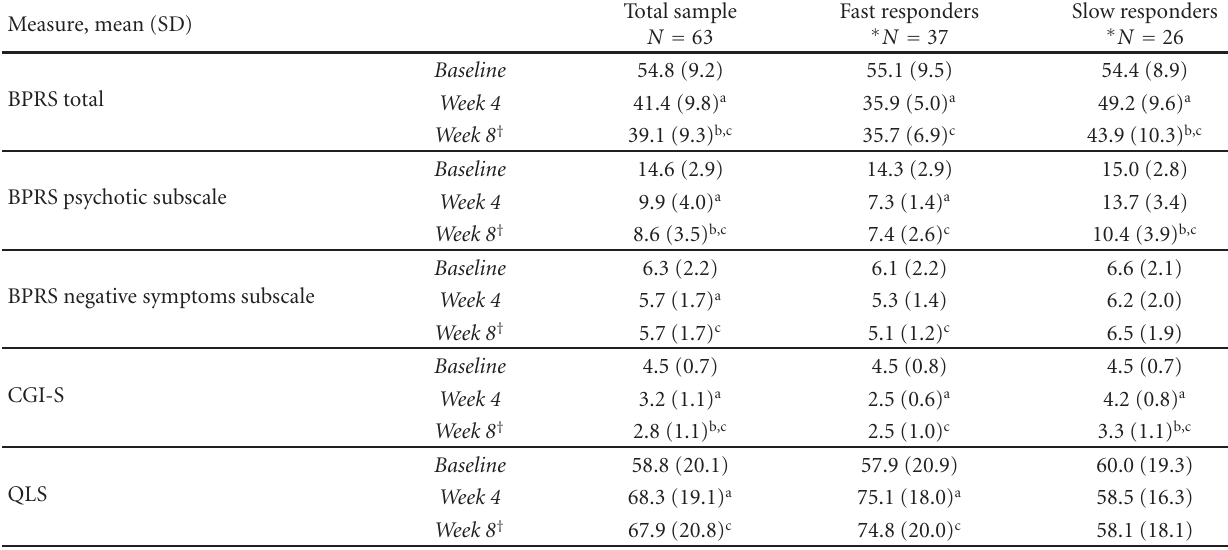
Table 2: Psychopathology and clinical improvement measures at baseline, week 4 (end of Phase I) and week 8 (end of Phase II). Measure, mean